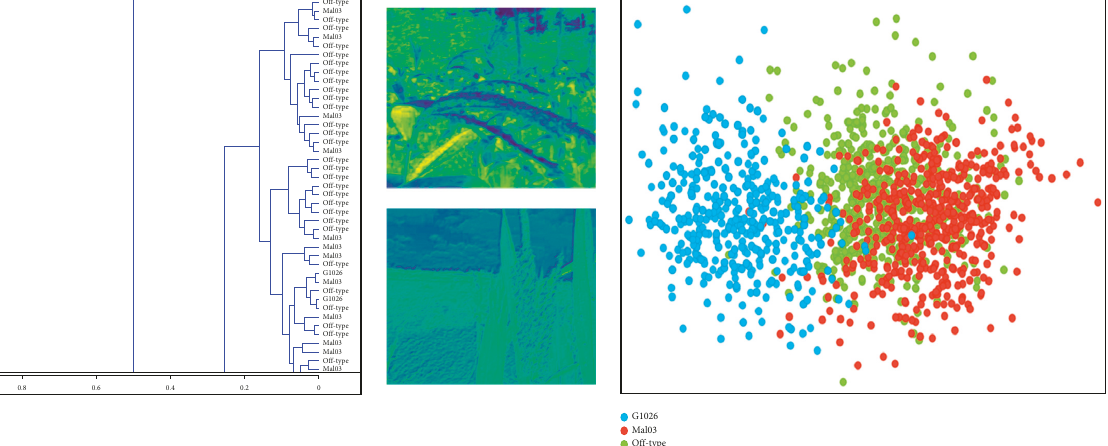
Figure 11: Dendrogram and multidimensional data projection MDS analysis of tassel.